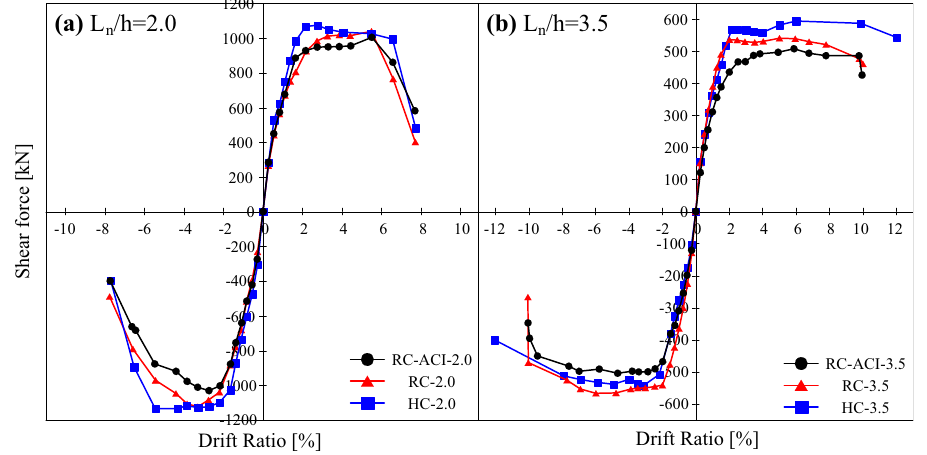
Fig. 11 Envelopes of shear-drift